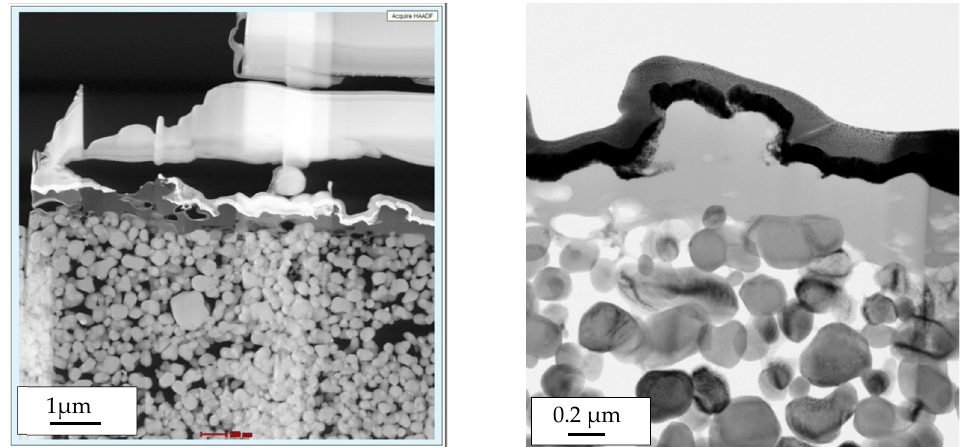
Figure 5. Scanning transmission electron microscopy (STEM) images of the Layer-by-Layer (LbL) coat of the ceramic support membrane.